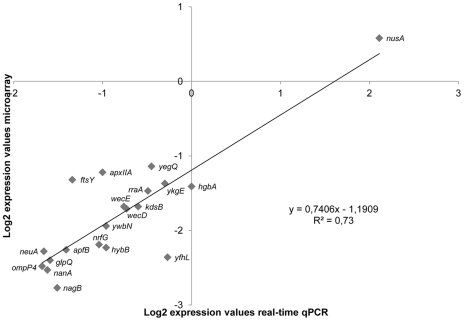
Validation of microarray results by qPCR.Microarray and qPCR analyses were applied to measure in vivo expression changes between 6 h p.i. and 48 h p.i. for 20 selected A. pleuropneumoniae genes. The log2 transformed microarray data were plotted against the log2 transformed qPCR data for correlation analysis.